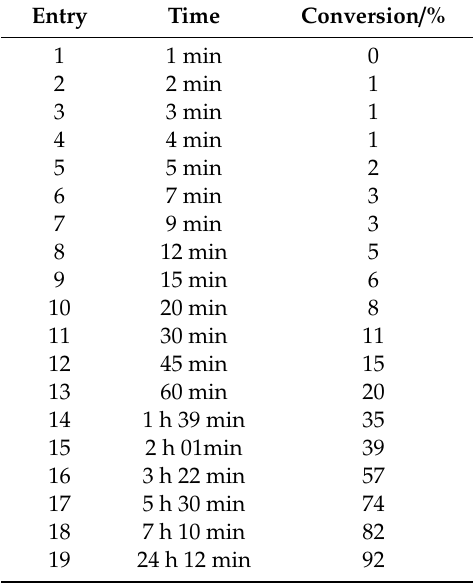
Table A11. Reduction of acetophenone ( 1 ) to 1-phenylethanol ( R )- 2 . Change from standard procedure: 200 mM potassium phosphate bu ff er trial 2.